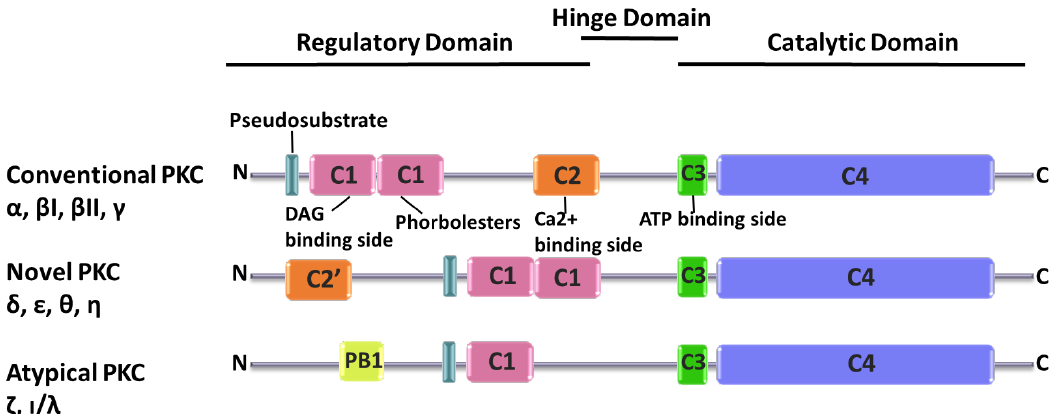
Figure 1. Domain structures of Protein kinase C (PKC) isozymes. C1 domain (pink), C2 domain (orange), C3 domain (green), Pseudosubstrate (turquoise), C4 domain (blue) and PB 1 (Phox and Bem1) domain